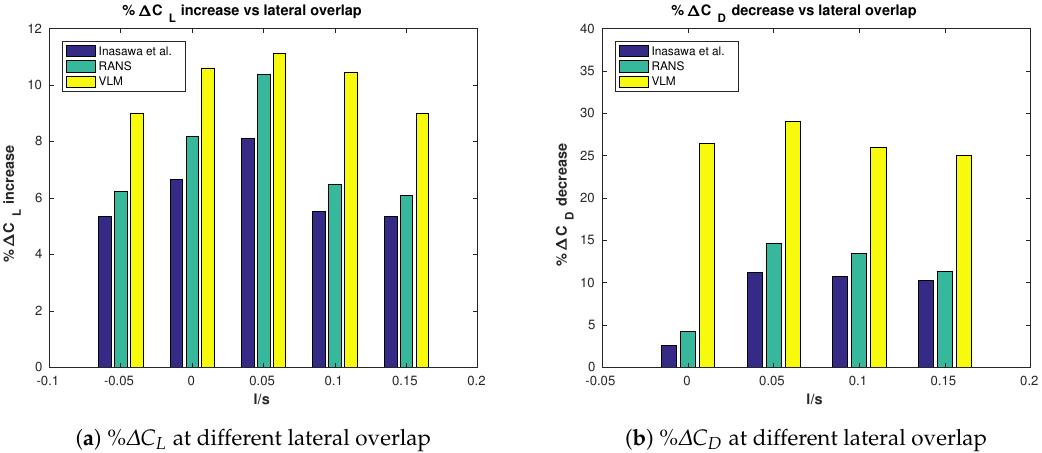
Figure 9. Percentage variations of drag (% ∆ C D ) and lift (% ∆ C L ) at five different displacements; solutions are shown for RANS and VLM and compared with the experimental data